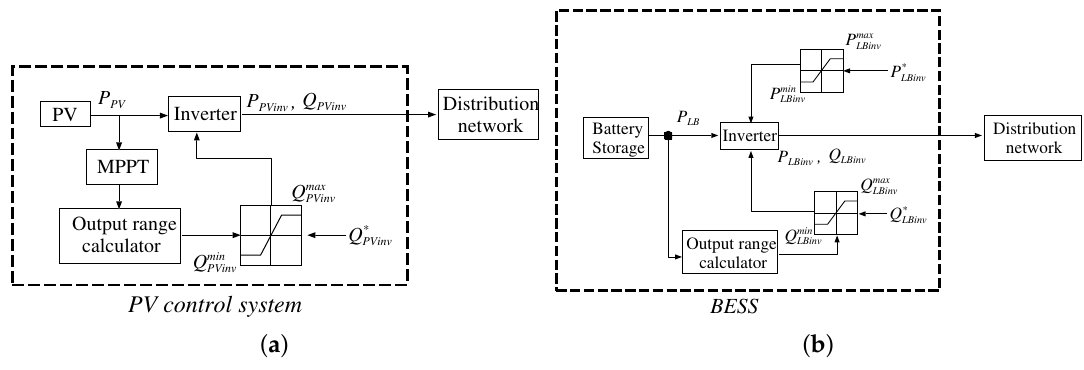
Figure 3. Active and reactive power control system. ( a ) Interfaced inverter of the PV system and ( b ) inverter of BESS at the interconnection